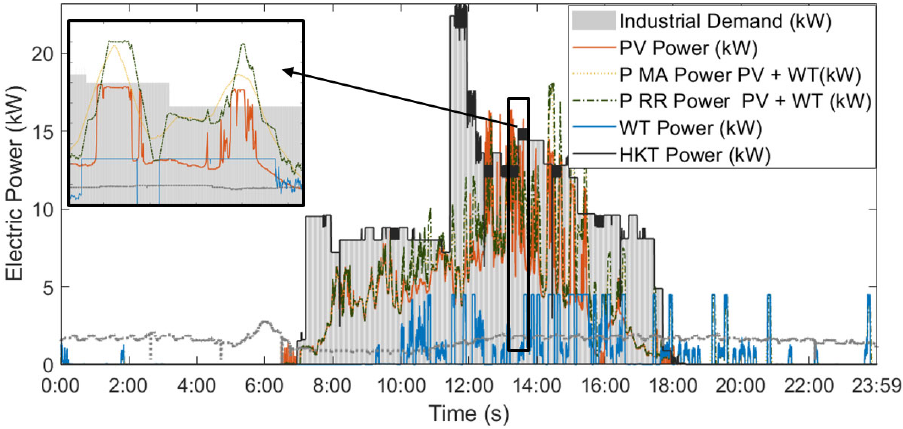
Figure 12. Control algorithm result, power smoothing methods for a system (PV + WT + HKT + LI + SC).